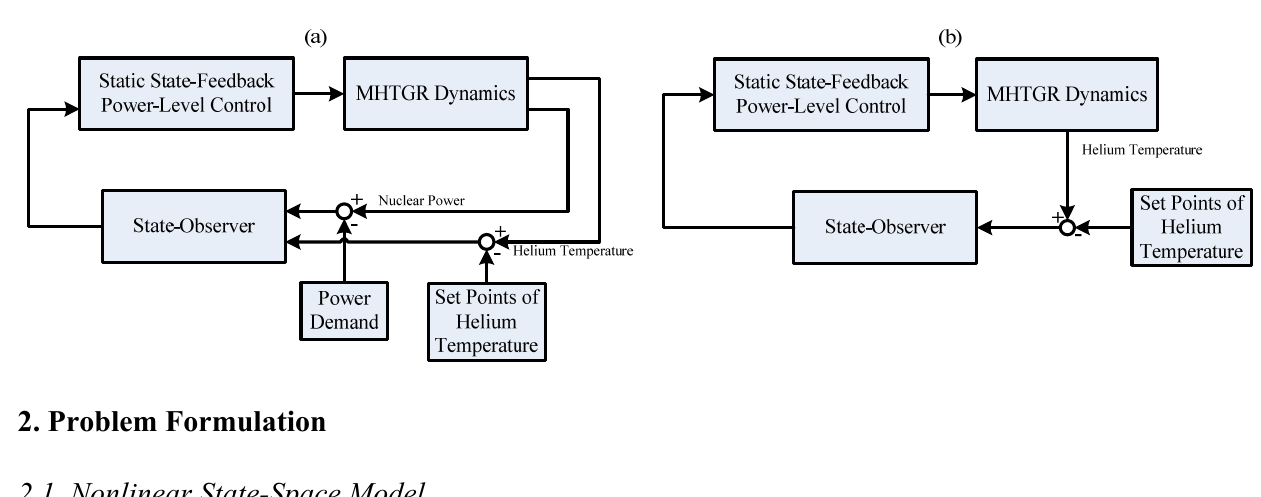
Figure 3. Structures of feedback